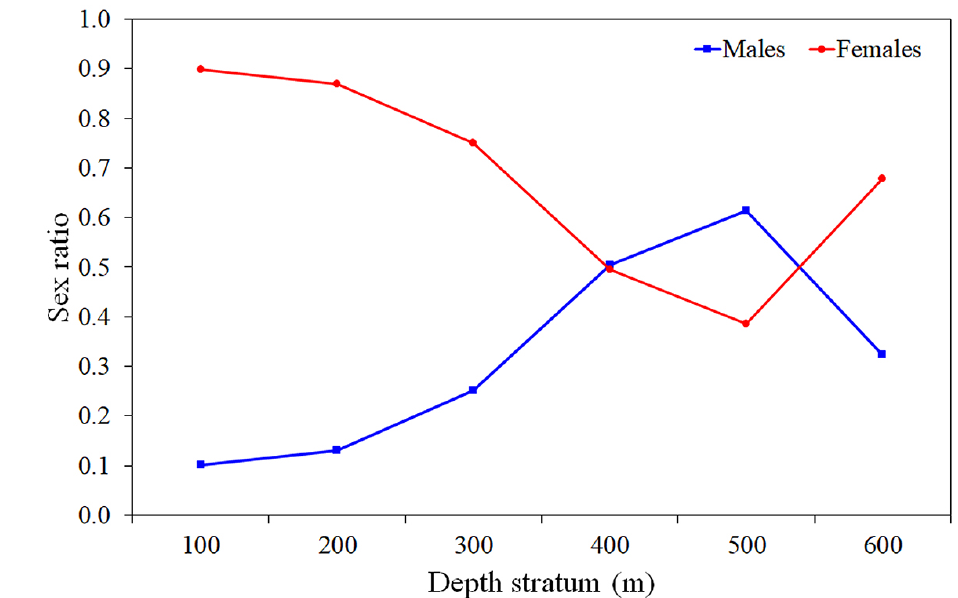
Figure 5. Sex ratio of Plesionika edwardsii by depth stratum in the Azorean region during the period 1999–2000.